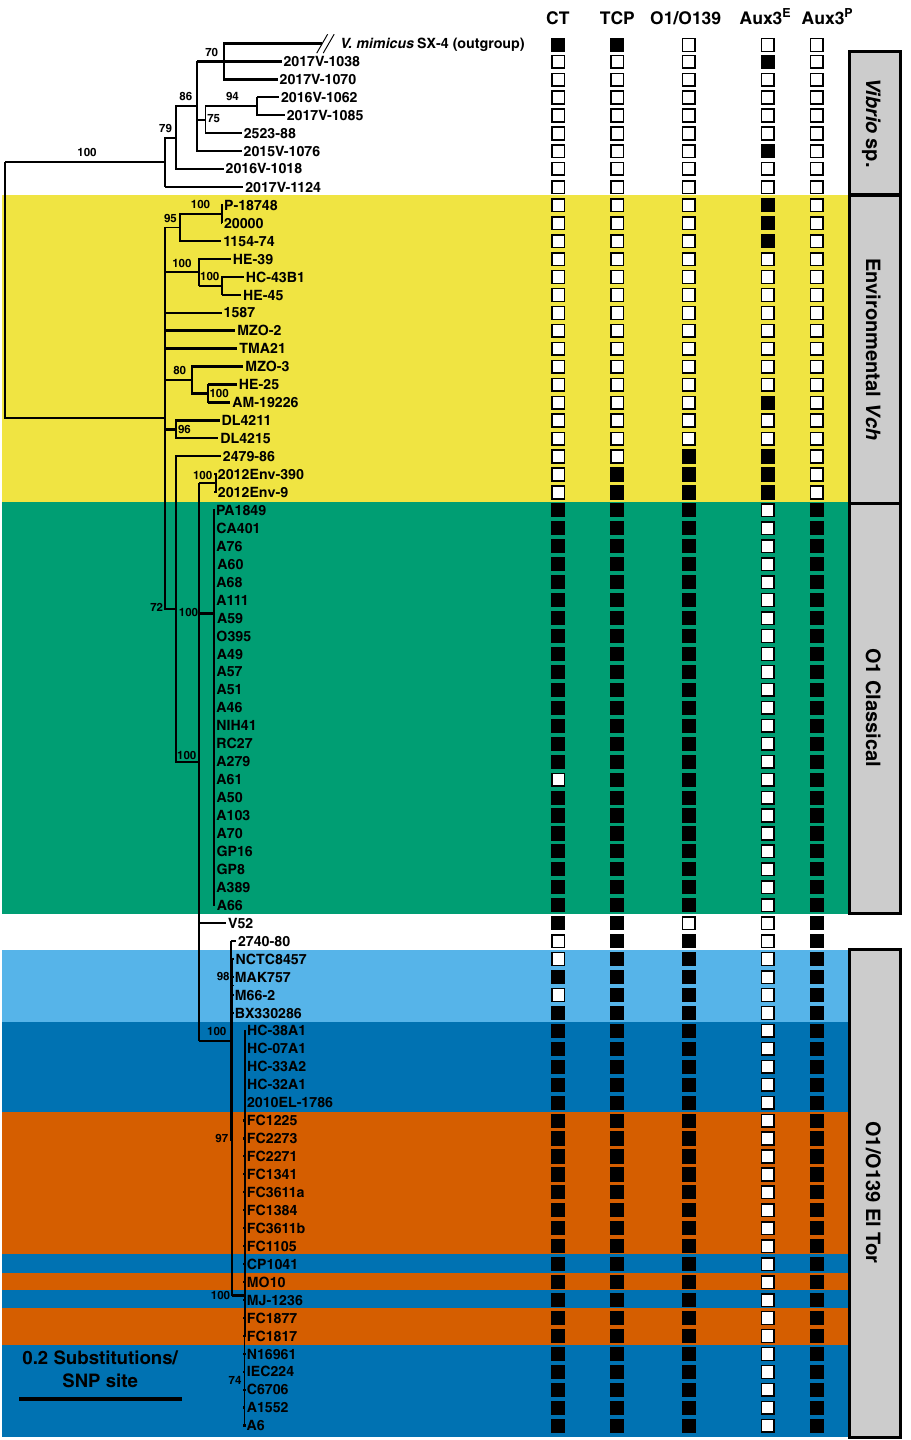
Fig. 3 The Aux3 element is enriched in pandemic V. cholerae and sporadically distributed in environmental strains. A phylogenetic tree was constructed using the GTR Gamma Maximum likelihood model in RAxML based on core genome SNP alignment of 69 V. cholerae , 8 Vibrio sp. and 1 V. mimicus genome sequences. Bootstrapping support values are indicated next to their respective branches. Nodes with support values <70 were collapsed. Presence (black square) or absence (white square) of CT, TCP, O1/O139 antigen and the Aux3 E or Aux3 P module is indicated. Environmental (yellow), O1 Classical (green), Pre-7th Pandemic O1 El Tor (light blue), 7th Pandemic O1 El Tor (dark blue) and O139 (red) strains are